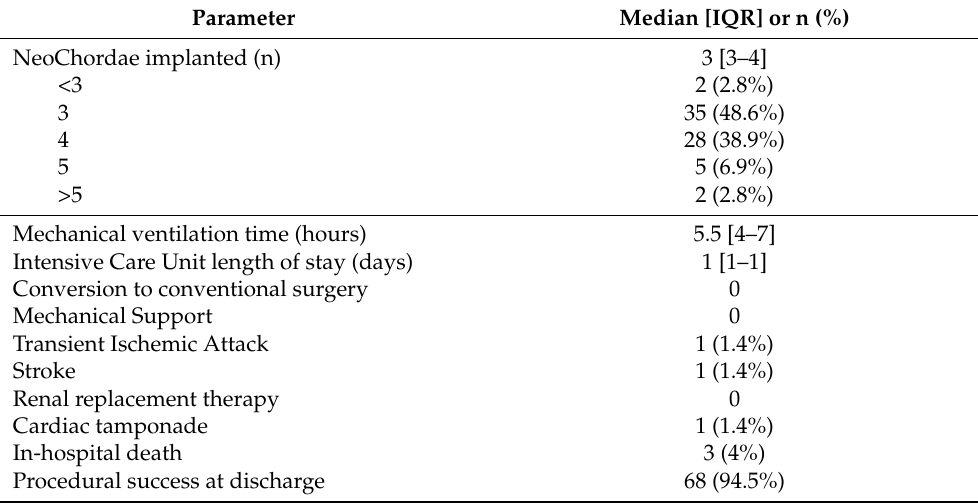
Table 3. In-hospital